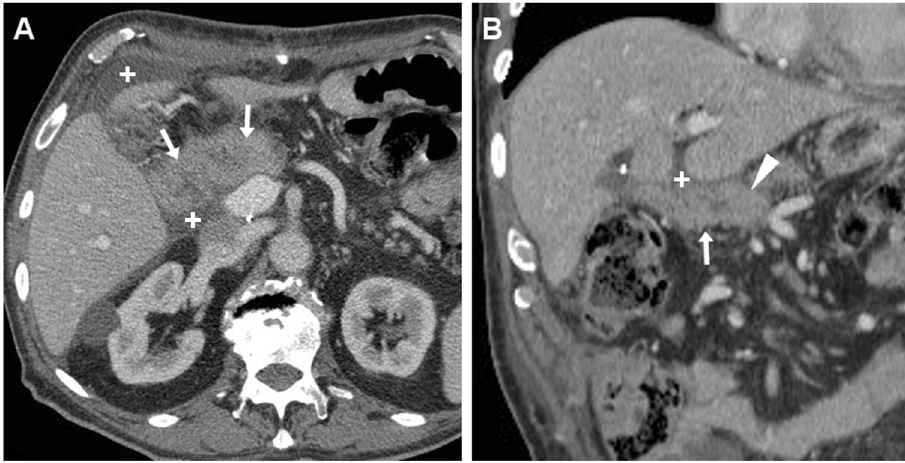
Fig. 4 a, b Transient oedema of the MJL after uncomplicated PD in a 72-year-old man. Contrast- enhanced CT showed mildly thickened MJL walls ( arrows